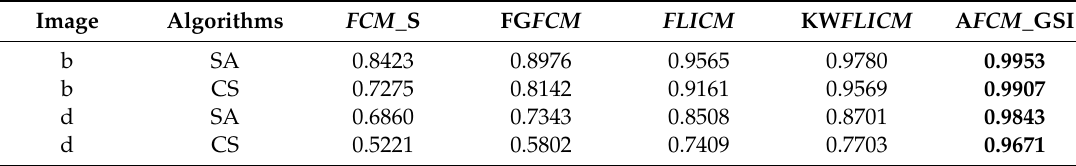
Figure 3. ( a ) segmented image by FCM _S; ( b ) segmented image by FG FCM ; ( c ) segmented image by FLICM ; ( d ) segmented image by KW FLICM ; ( e ) segmented image by A FCM _GSI. Table 1. Segmentation accuracy (SA) and comparison scores (CS) of five algorithms on noisy synthetic image 1 and